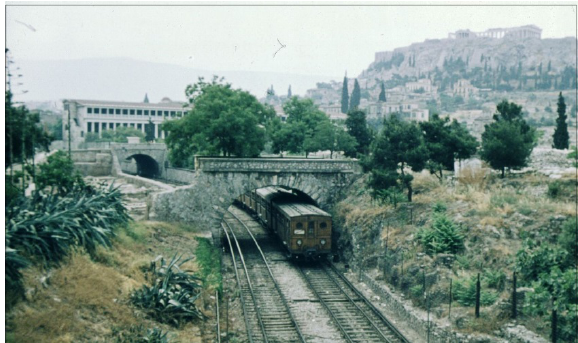
Figure 3. Original Athens metro line after doubling of the track